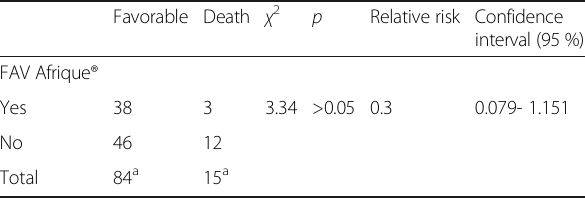
Table 2 Outcome according to the administration or not of the antivenom FAV-Afrique® (data from CAPM,